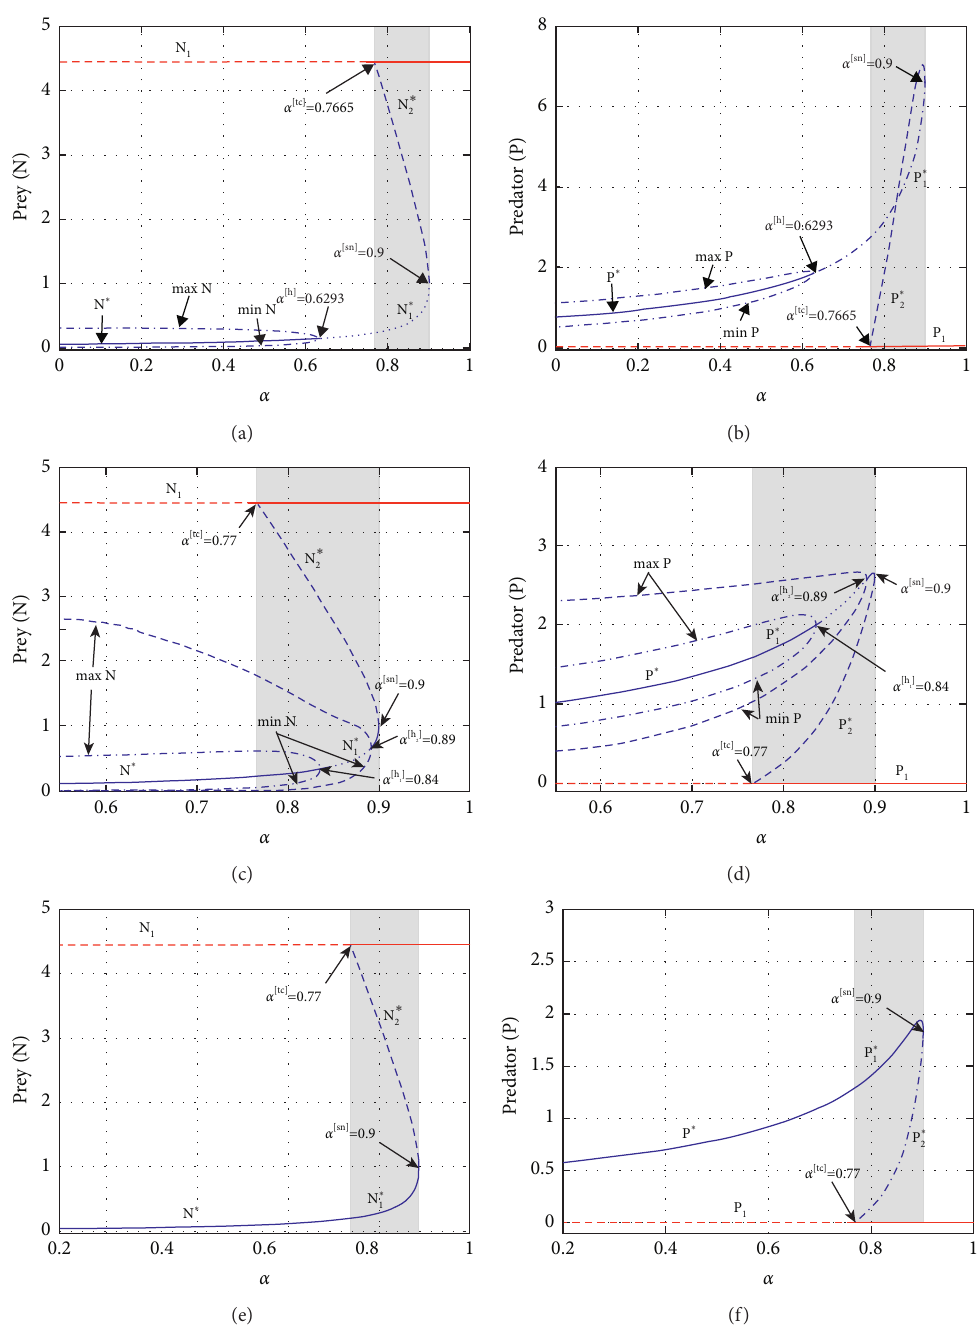
Figure 6: Bifurcation diagram of codimension-1 for the bifurcation parameter α . (a, b) The change of population biomass for the lower fear level, k � 0 . 1, in which case a subcritical Hopf bifurcation at α [ h ] � 0 . 6293, a saddle-node bifurcation at α [ sn ] � 0 . 9, and a transcritical bifurcation at α [ tc ] � 0 . 7665 occur. (c, d) The change of population biomass for the fear level k � 0 . 8, in which case another Hopf bifurcation at α [ h 2 ] � 0 . 89 occurs and that Hopf bifurcation is supercritical. But for larger fear level k � 1 . 5, both Hopf bifurcations disappear in (e, f). Multiple coexistence occurs in the grey-shaded region. Blue-coloured curve and red-coloured curve indicate the prey/predator biomass of E � ( N , P ) � (( r − d ) / a, 0 ) and E � ( N ∗ , P ∗ ) (or E ( N ∗ ,P ∗ ) and E ( N ∗ ,P ∗ ) ), respectively. Solid lines and dashed lines refer to the 1 1 1 2 2 1 2 2 1 1 2 2 stable and unstable behaviour of the system respectively. Dashed-dot curves indicate the max and min of prey/predator population. Other parameter values are fixed at r � 0 . 6 , η � 0 . 4 , d � 0 . 2 ,a � 0 . 09 ,c � 0 . 5 ,h � 0 . 007 , θ � 0 . 4 ,m � 0 . 01 􏼈 􏼉 . (a) Change of prey biomass for the bifurcation parameter α and fixed k � 0.1. (b) Change of predator biomass for the bifurcation parameter α and fixed k � 0.1. (c) Change of prey biomass for the bifurcation parameter α and fixed k � 0.8. (d) Change of predator biomass for the bifurcation parameter α and fixed k � 0.8. (e) Change of prey biomass for the bifurcation parameter α and fixed k � 1.5. (f) Change of predator biomass for the parameter α and fixed k �